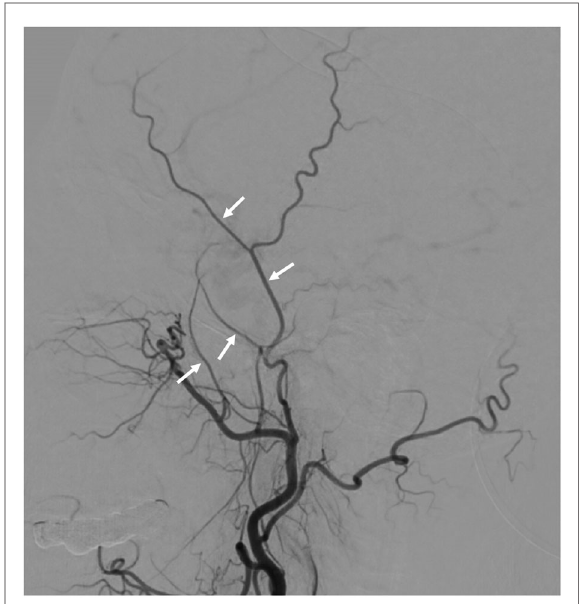
FIGURE 2 Example measurement sites for the super fi cial temporal artery (STA), the frontal branch of the STA (F-STA), the deep temporal artery (DTA) and middle meningeal artery (MMA) to allow comparison of preoperative and postoperative